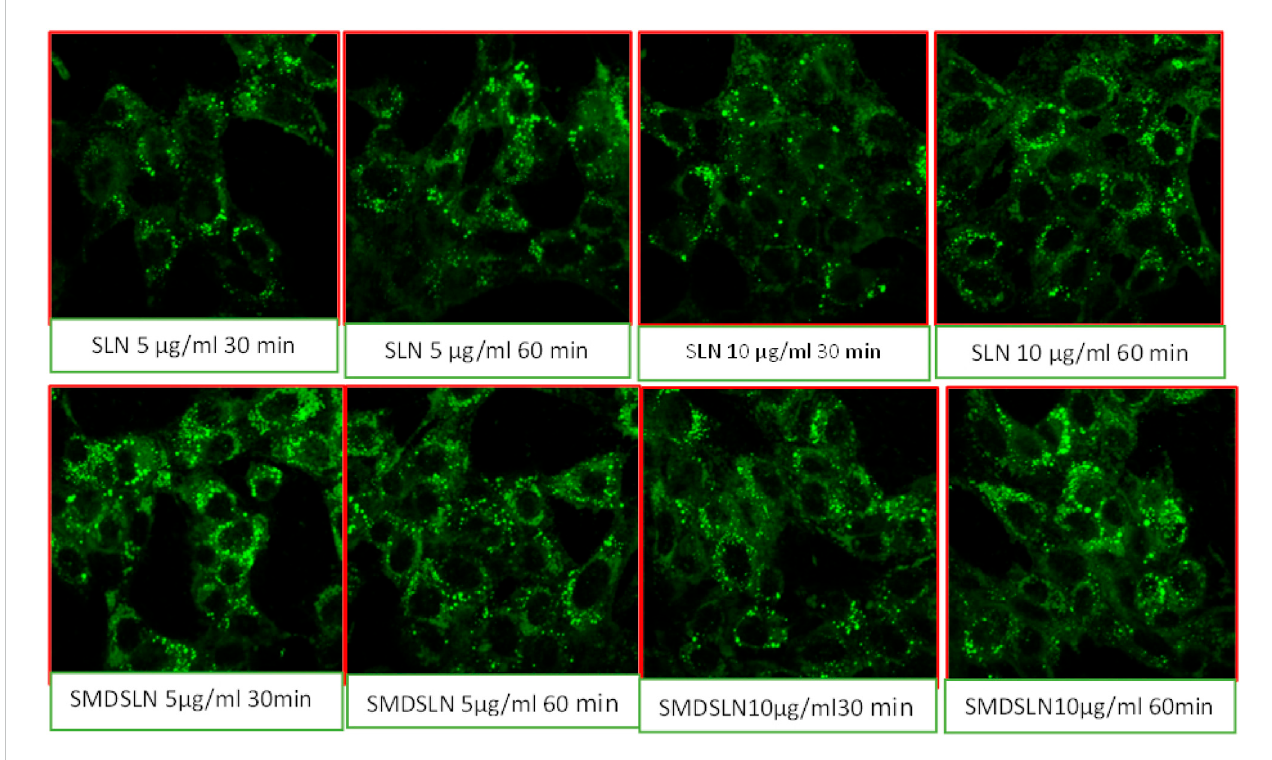
FIGURE 1 Qualitative cell uptake of developed SLN formulations by confocal